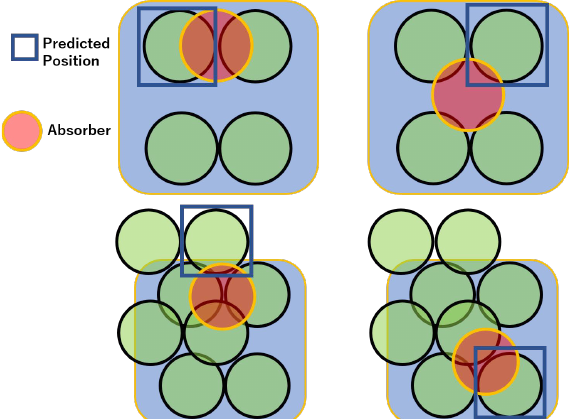
Figure 6. Results of position prediction for absorbers with offsets. Red circles are absorbers, and blue squares are predicted